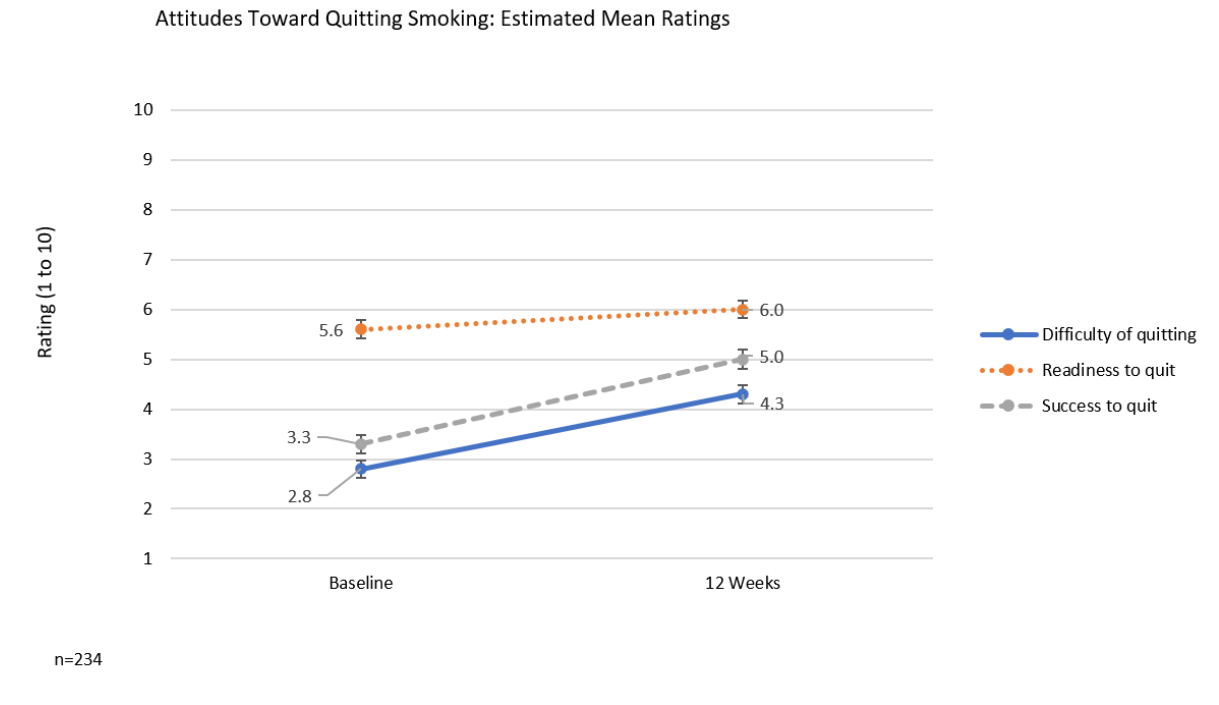
Figure 3. Attitudes towards quitting smoking, ratings (scale 1-10) at baseline vs. 12 weeks. Estimate of means and standard errors based on linear mixed model. Readiness to quit smoking (RTQ), Difficulty to quit smoking (DTQ), Success to quit smoking (STQ).